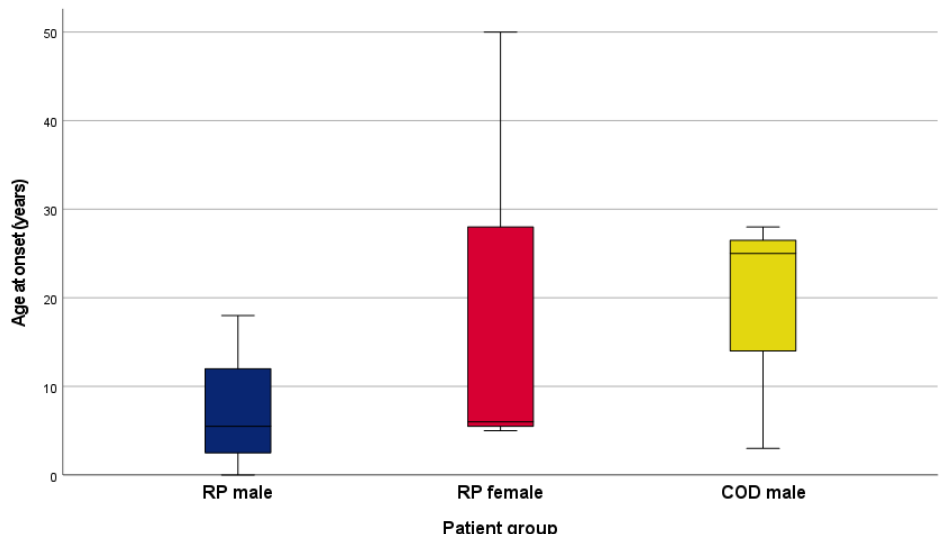
Figure 16. Boxplot chart showing age at onset in patients with RP and COD. Horizontal lines represent the median values, boxes represent half of the data for each group, and whiskers represent the remaining data.